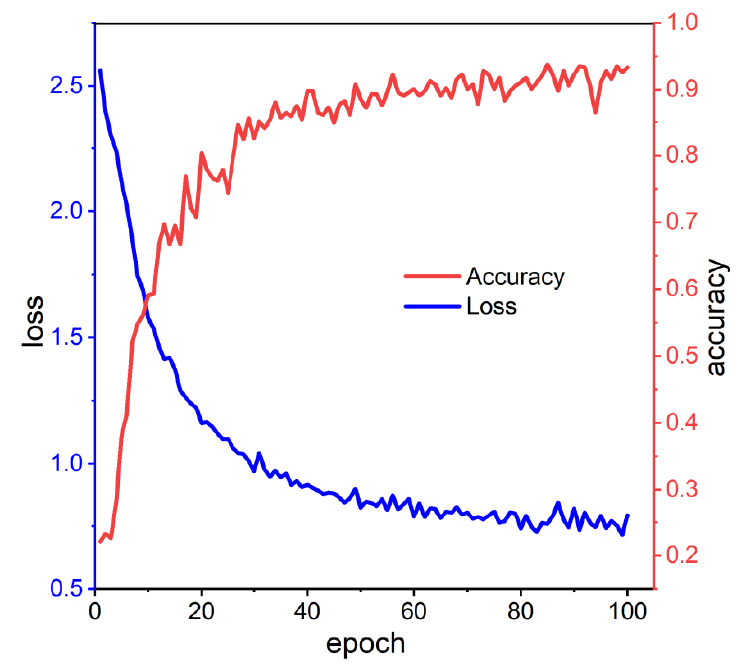
Figure 17. Loss and accuracy curves.